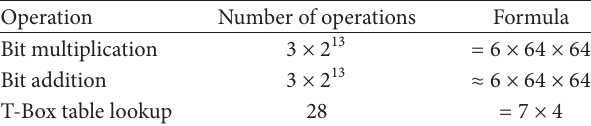
Table 1: Number of operations in the algorithm SHARK 𝑊 [𝐾] .